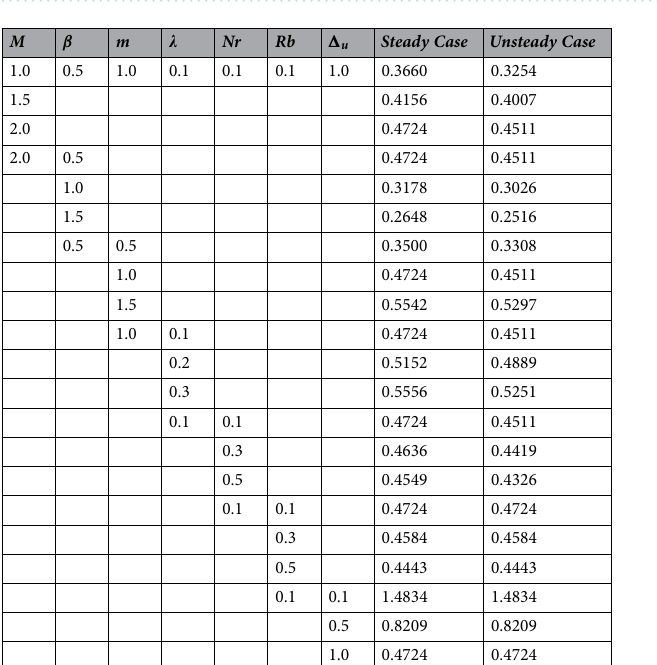
Figure 7. Fluctuation in motile density χ(η) with ( a ) Lb , ( b ) Pe and ( c ) δ .